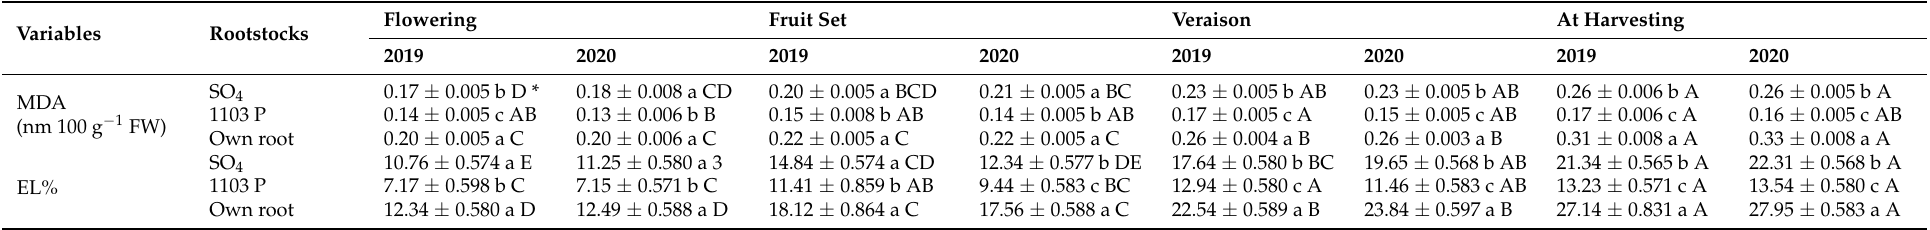
Table 4. The effect of rootstocks (SO 4 , 1103 Paulson, and own root) on malondialdehyde (MDA), and electrolyte leakage percentage were assessed four times during two growth seasons (2018–2019) on various berry developmental phases (flowering, fruit set, veraison, and at harvest time) of “superior seedless” vines.